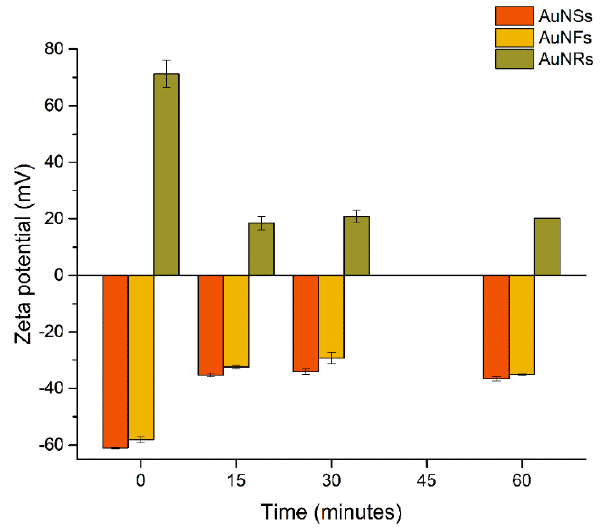
Figure 2. Zeta potential values of AuNPs before and after incubation with urine samples.